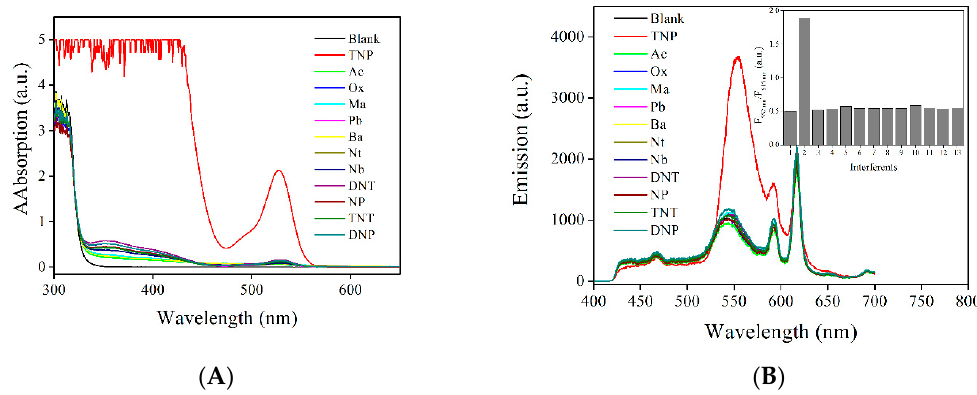
Figure 9. Absorption ( A ) and emission ( B ) spectra of RS6h@EuBTC suspension in ethanol (0.1 mg/mL) in the presence of interferents (100 μ M) , including Ac (acetic acid), Ox (oxalic acid), Ma (malonic acid), Pb (Phenol), Ba (benzoic acid), Nt (p-nitrotoluene), Nb (4-nitrochlorobenzene), DNT (2,4-dinitrotoluene), NP (3-nitrophenol), TNT (trinitrotoluene), DNP (2,4-dinitrophenol). Inset: F 552 nm /F 615 nm ratios under interferents, 1 = blank, 2 = TNP, 3 = Ac, 4 = Ox, 5 = Ma, 6 = Pb, 7 = Ba, 8 = Nt, 9 = Nb, 10 = DNT, 11 = NP, 12 = TNT, 13 = DNP.